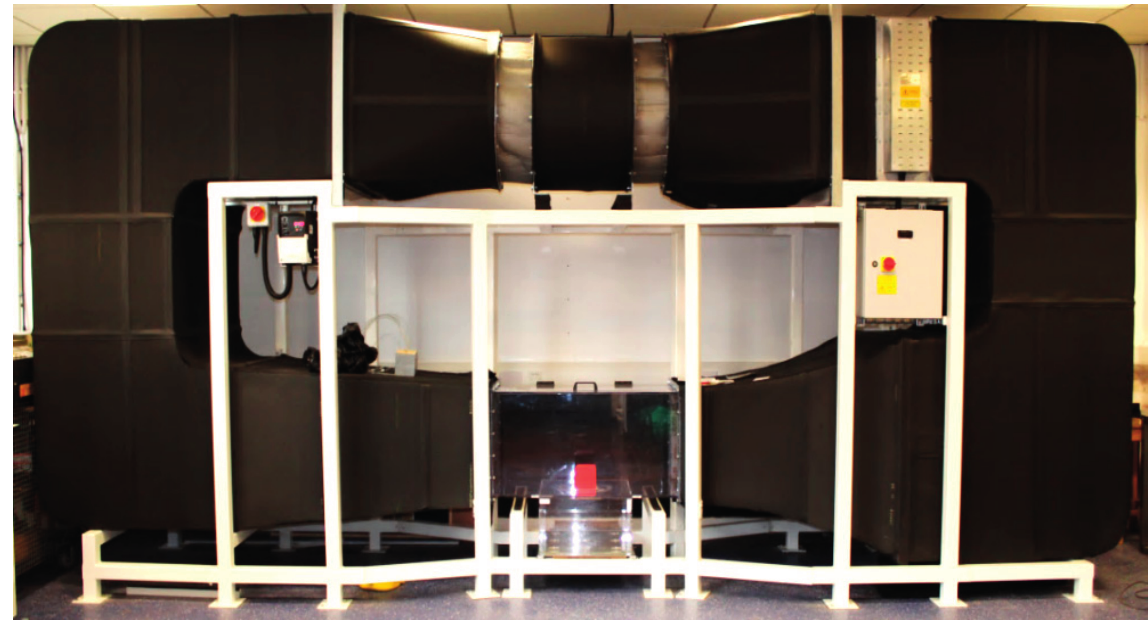
Figure 11. Closed-loop subsonic wind tunnel system for wind tower testing